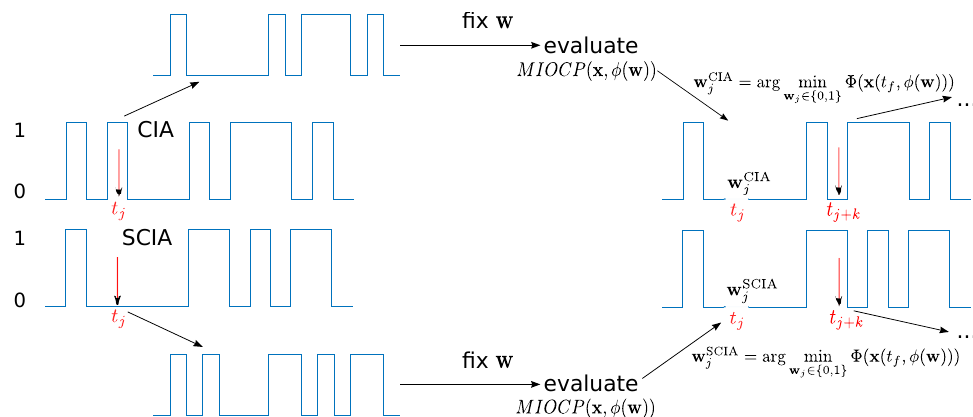
Figure 1. Example visualization of the GreedyTime algorithm. We use two candidate control solutions, here from CIA and SCIA, to construct new candidates. We perform an enumeration between 0 and 1 at all times t j when the input vectors differ. Then, the two candidate solutions w are fixed and we evaluate (MIOCP) for both vectors. We compare the resulting objective function values with their previous values. Moreover, the binary w j values with the lower objective values are fixed in the candidate solutions. This procedure is repeated on the next grid point with unequal candidate